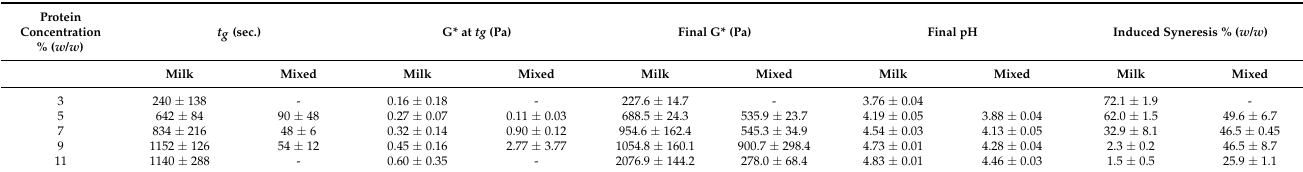
Table 3. Gel point ( t g ), complex modulus (G*), and corresponding pH for mixed protein suspensions and milk